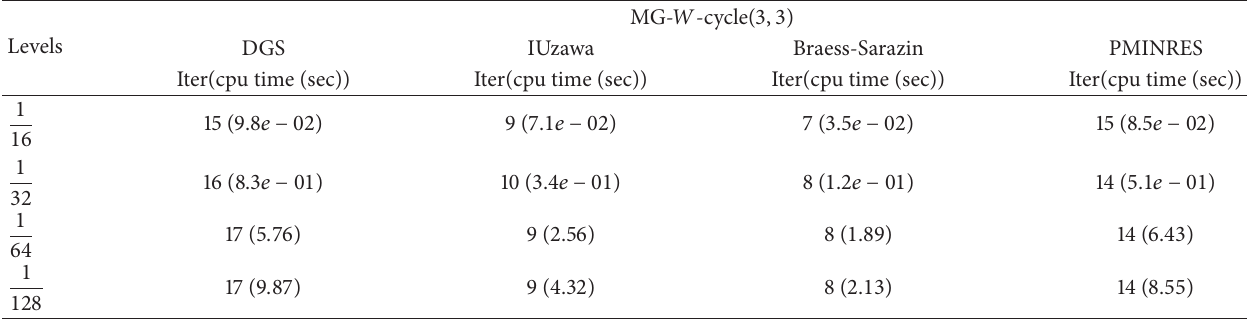
Table 5: Number of iterations and CPU time for multigrid ( 𝑊 -cycle) with different smoothers and smoother preconditioner approximations at different levels of refinement, tolerance = 10 −6